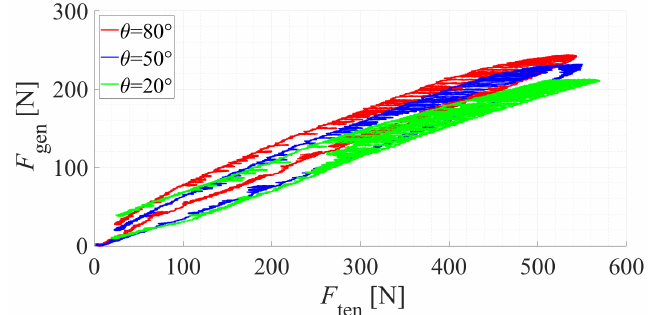
Figure 7. The substantiated input–output (a tensile force F ten versus a generated force F gen ) relation- ship of the SJLM. From Figure 7, the slopes of the F ten versus F gen curve are approximately (at F ten =